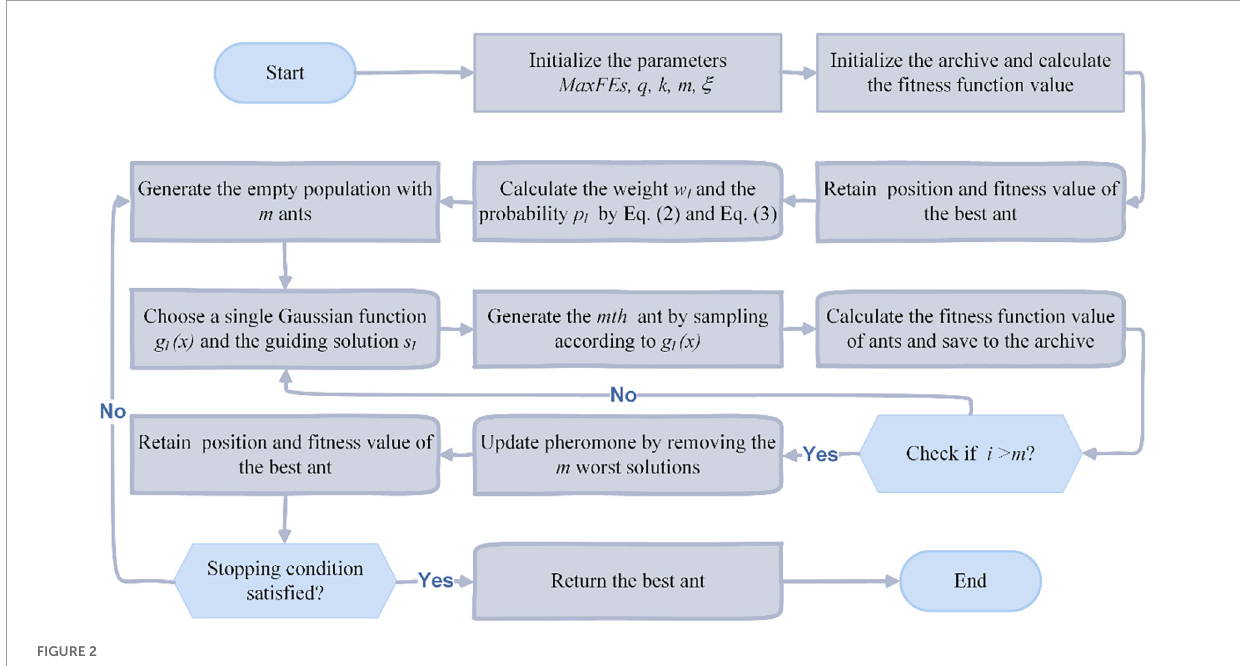
FIGURE2 The flowchart of